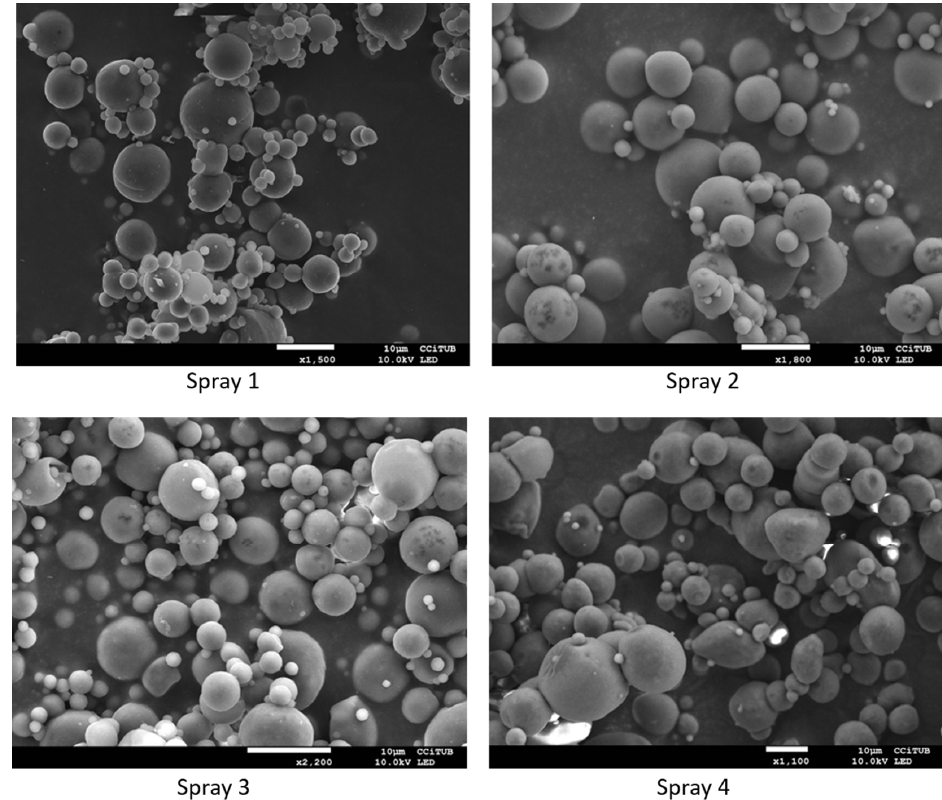
Figure 3. SEM images of PGZ-NPs after spray drying.